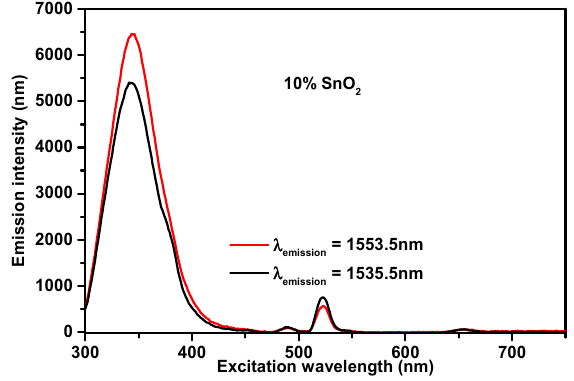
Figure 5. Excitation spectra detected at 1553.5 nm and 1535.5 nm of 90SiO 2 -10SnO 2 :0.5Er 3+ monoliths heat treated at 900 °C for 40 h.